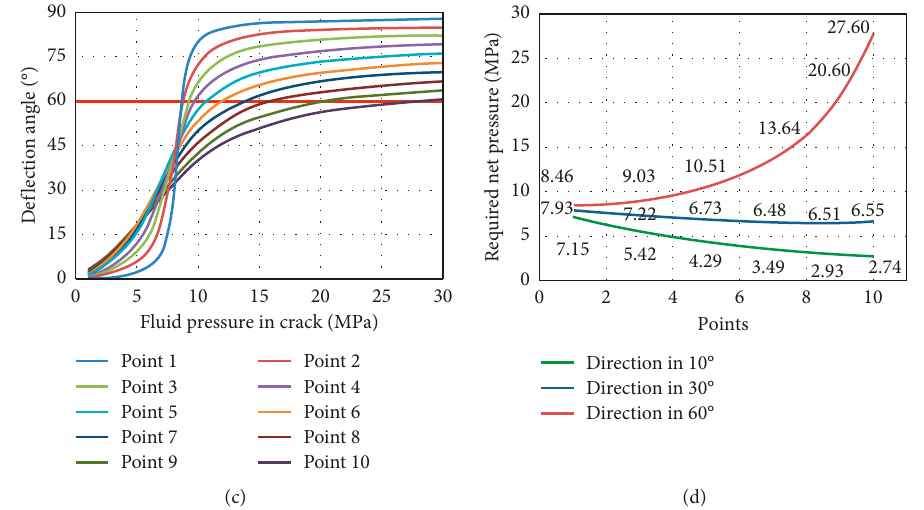
Figure 15: Deflection angle of the principal stress at the target point changes with pressure: (a) 10 ° ; (b) 30 ° ; (c) 60 ° , and (d) pressure scheme at three angles.